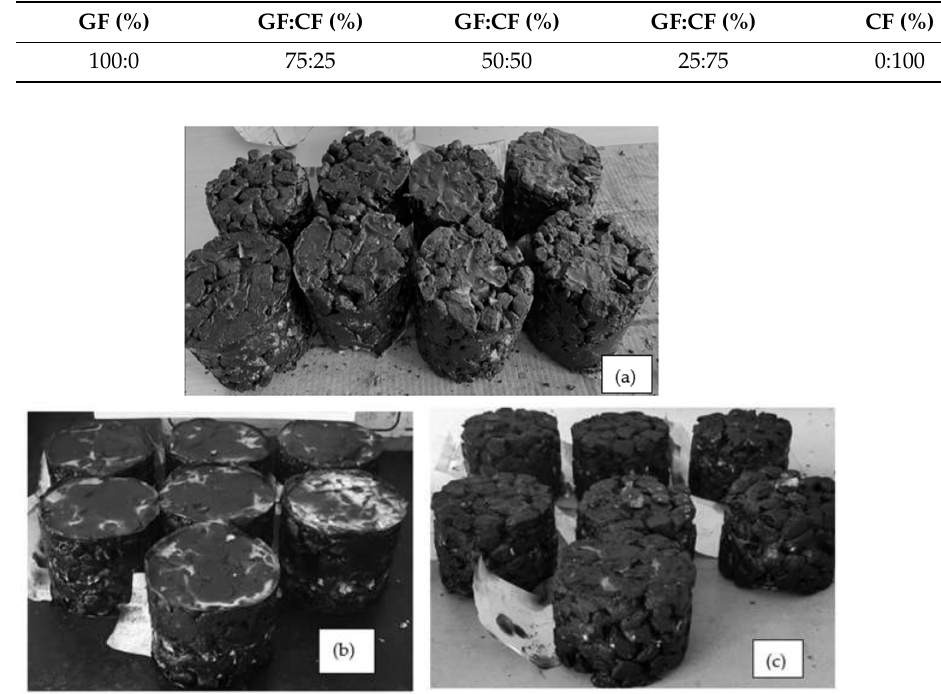
Table 7. Design mix of glass and carbon fibers.